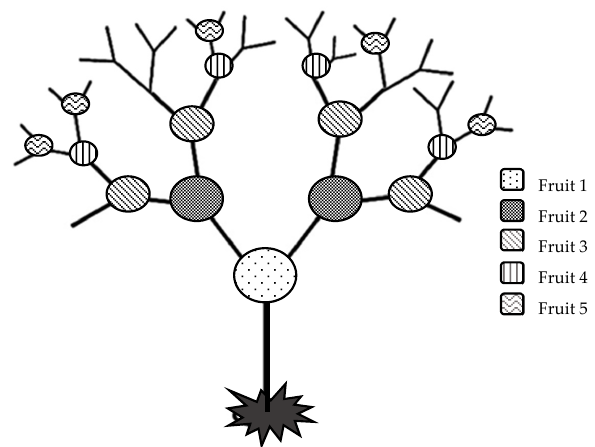
Figure 1. Level of fruit picking position on plant.